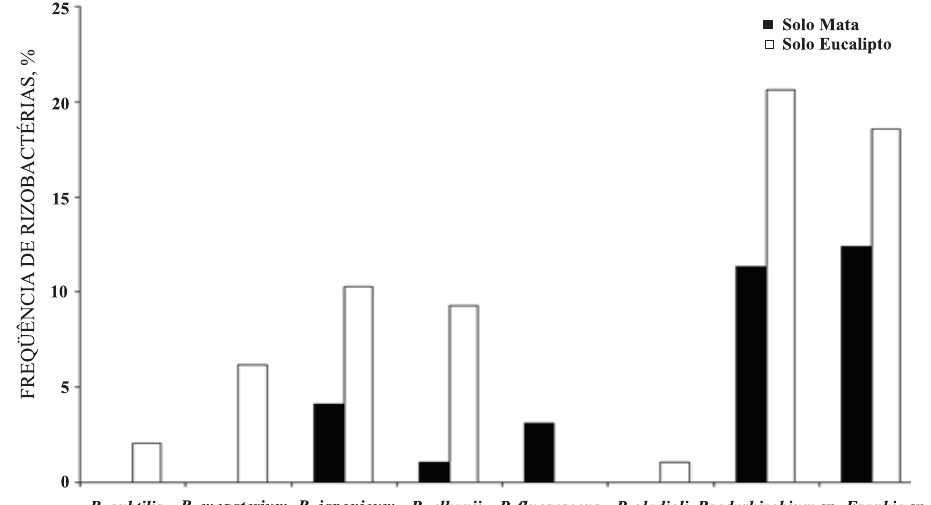
Figura 1. Distribuição de rizobactérias promotoras de crescimento de plantas, observadas nos solos sob mata e sob Eucalyptus sp. B. subtilis ( Bacillus subtilis ), B.megaterium ( Bacillus megaterium ), B.japonicum (Bradyrhizobium japonicum), B.elkanii ( Bradyrhizobium elkanii ), P.fluorescens ( Pseudomonas fluorescens ) e P. gladioli ( Pseudomonas gladioli